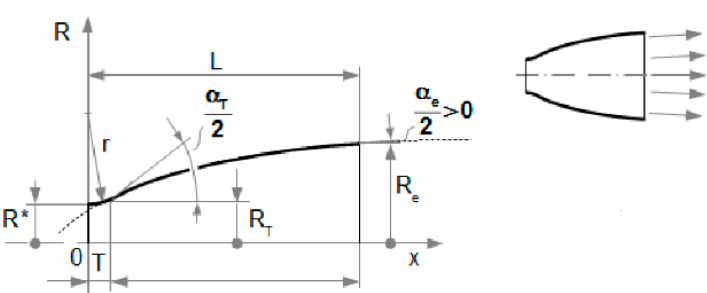
Figure 7. Laval nozzle—Bell nozzle. Reprinted from ref. [26].